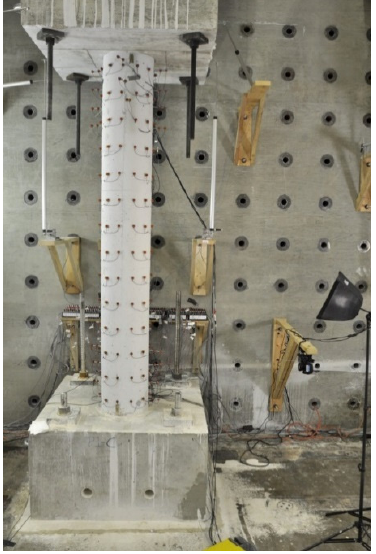
Figure 5. The concrete column specimen after casting.